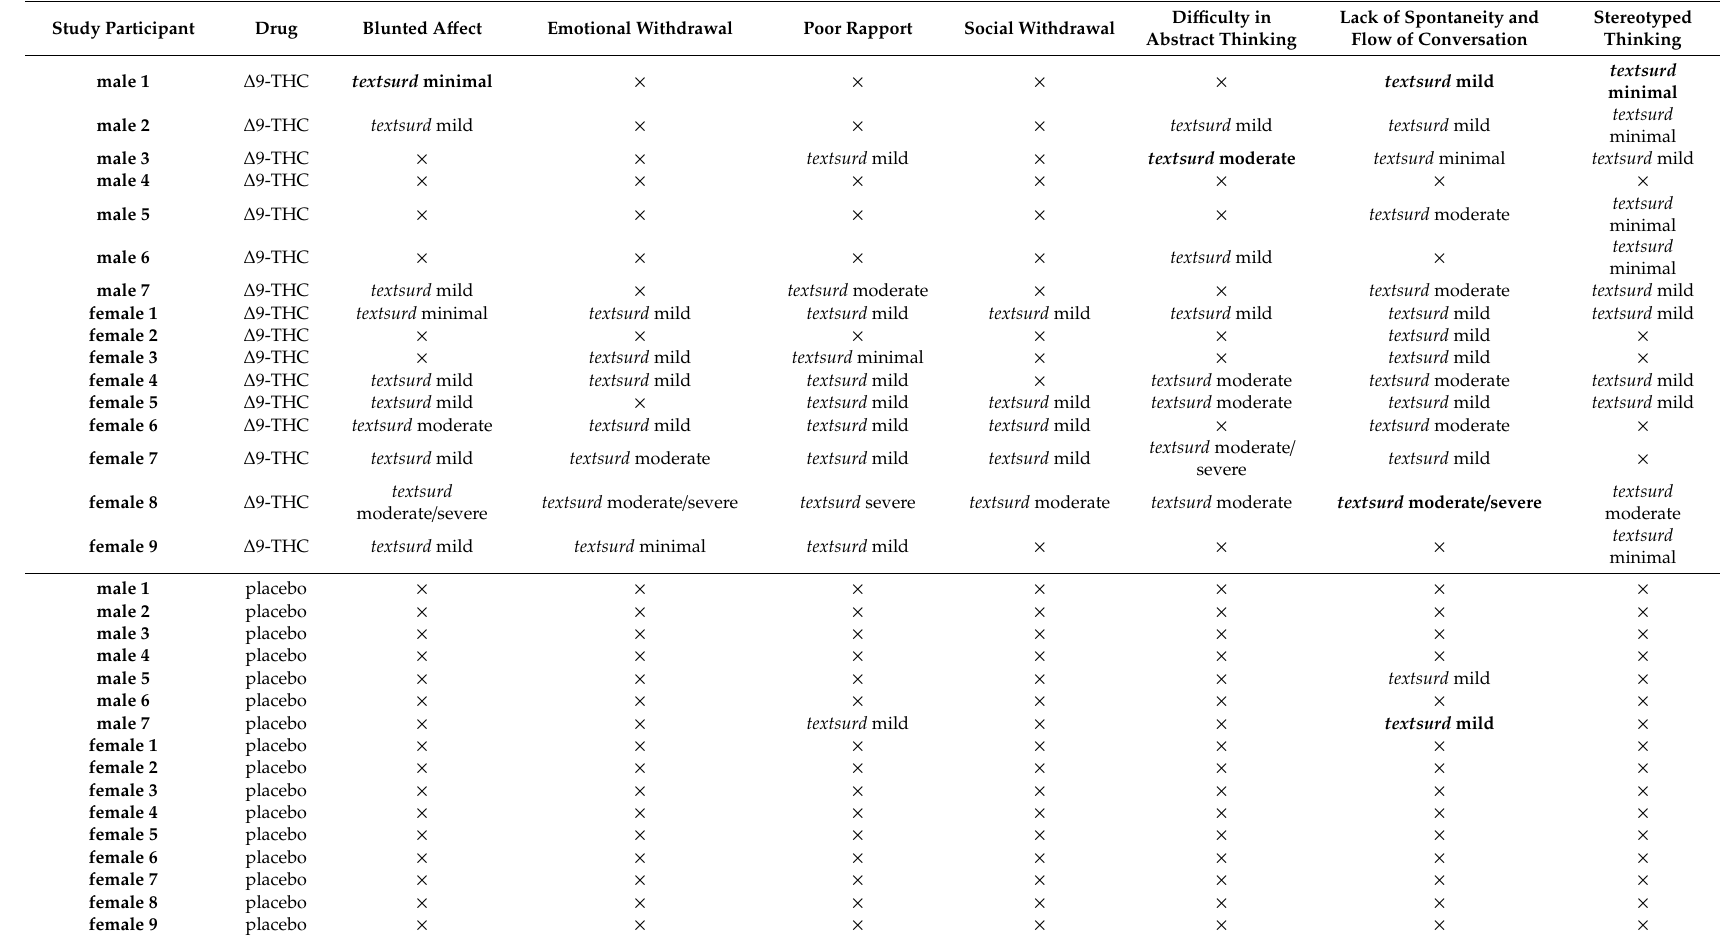
Table 2. Psychosis-related negative